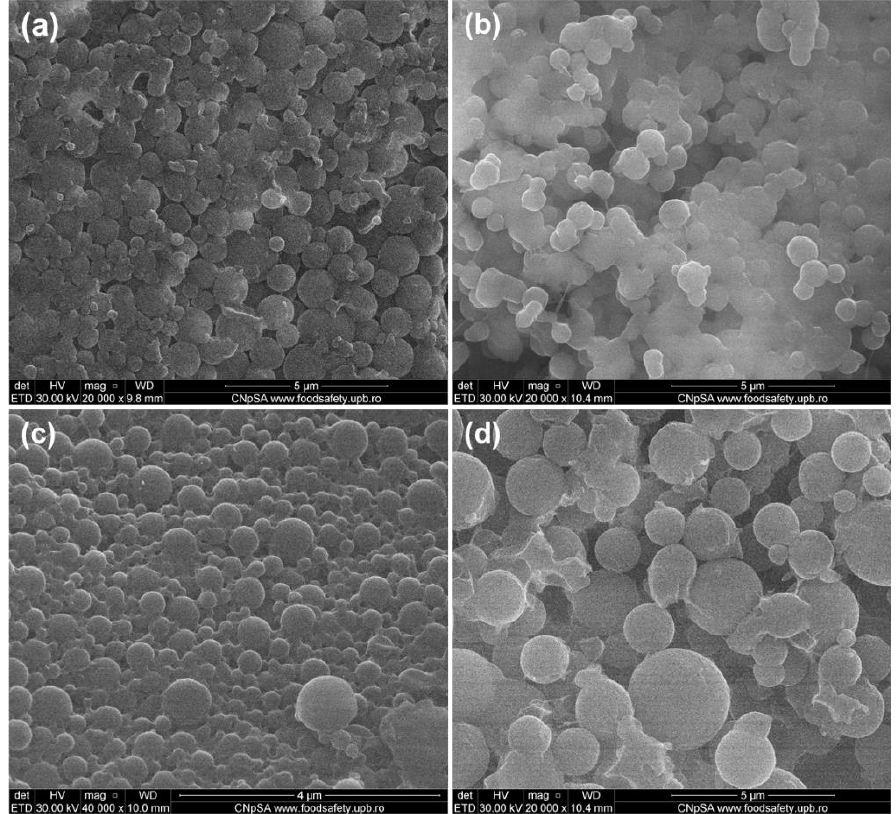
Figure 1. SEM micrographs of ( a ) P(3HB-3HV)-CS, ( b ) P(3HB-3HV)-CS-Bac, ( c ) P(3HB-3HV)-CS-Neo and ( d ) P(3HB-3HV)-CS-Kan spheres.